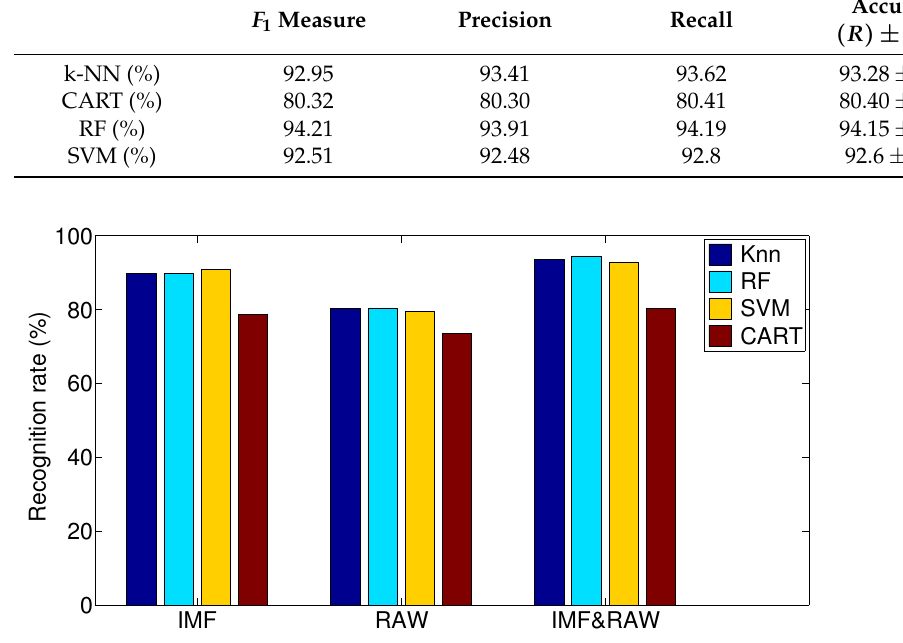
Figure 3. Obtained results in terms of recognition rate for each classifier using extracted/selected features from EMD, raw and EMD and raw